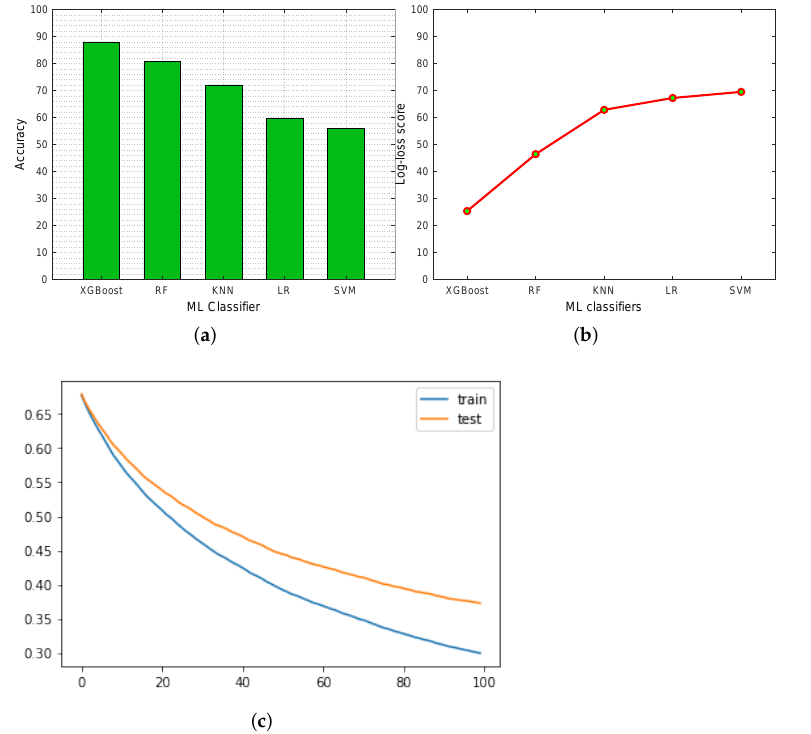
Figure 3. Performance evaluation of ML classifiers. ( a ) Accuracy. ( b ) Log_loss score. ( c ) Valida- tion curve. Table 4. Comparison of ML classifiers’ performance for different